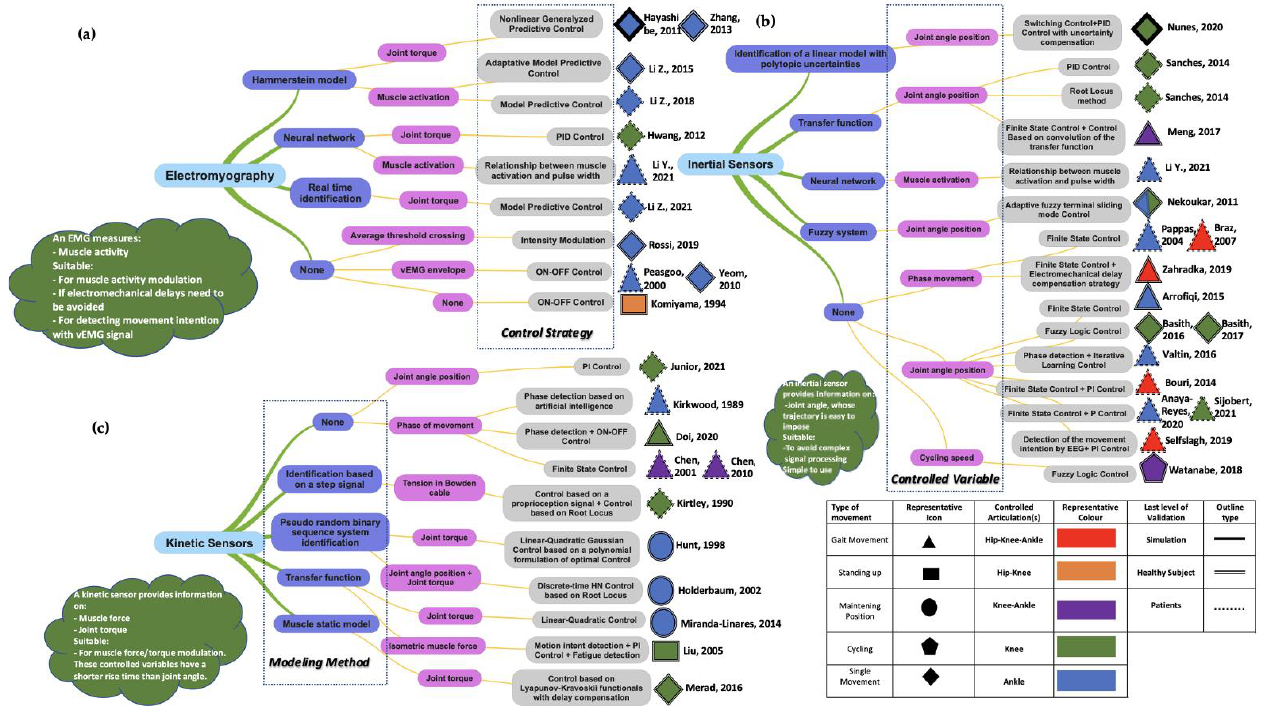
Figure 3. Article selection strategy. The green boxes justify the considered articles. The red boxes justify the ejected articles.